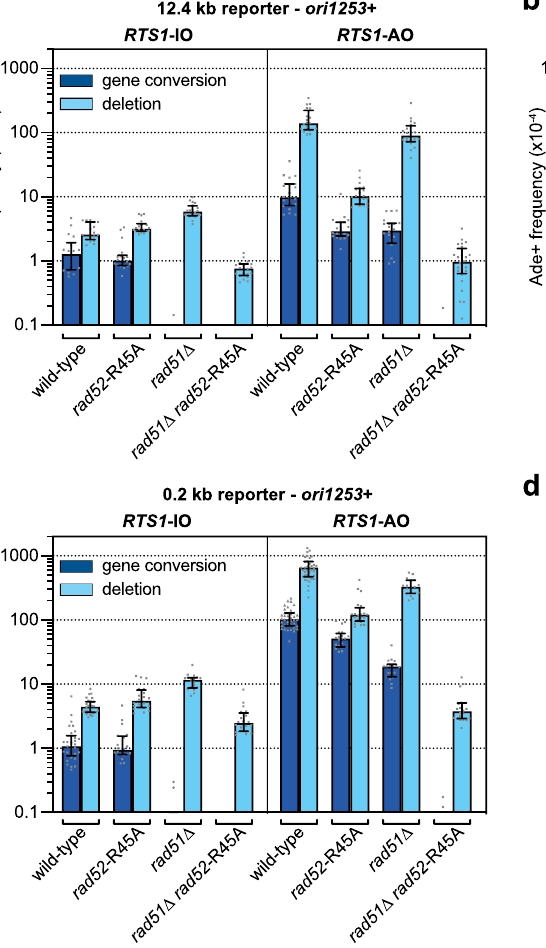
Fig.5|Rad52 ’ sDNAannealingactivityisrequiredforRDR-associatedtemplate switching. a Frequency of spontaneous ( RTS1 -IO) and RTS1 -AO-induced Ade + recombinants in ori-1253 + strains carrying the 12.4kb reporter. b Frequency of spontaneous ( RTS1 -IO) and RTS1 -AO-induced Ade + recombinants in ori-1253 Δ strains carrying the 12.4kb reporter. c Frequency of spontaneous ( RTS1 -IO) and RTS1 -AO-induced Ade + recombinants in ori-1253 + strains carrying the 0.2kb repor- ter. a – c Data are presented as median values±interquartile range with individual